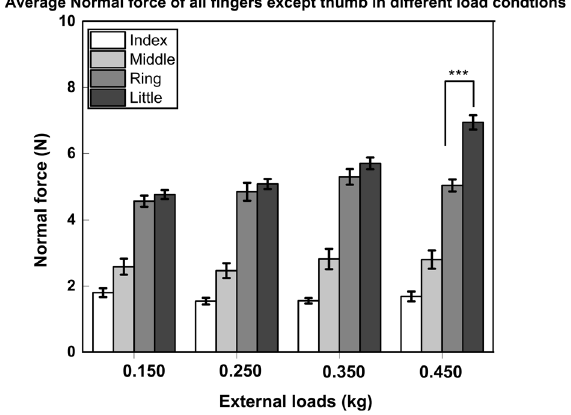
Figure 2. Average Normal force of Index, Middle, Ring, and Little fingers under different loading conditions. Little finger normal force (represented in black) was found to be statistically ( p < 0.0001) greater than the ring finger normal force (represented in dark shaded grey) in the 0.450 kg loading condition. The ring and little finger normal forces were found to be statistically equivalent under remaining loading conditions. The columns and bars indicate means and standard errors of means. (Note: *** represents significance of less than